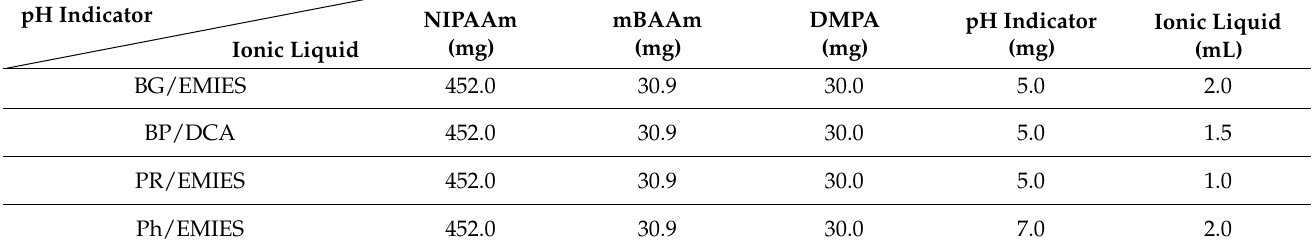
Table 1. Chemical composition of the different ionogel materials used for the fabrication of the pH